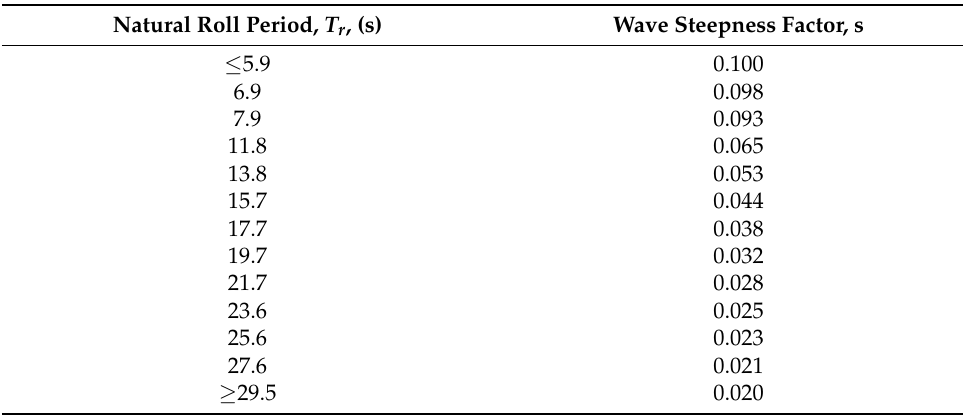
Figure 11. Standard wave steepness table. Table 10. Wave steepness table AHD data (full year).